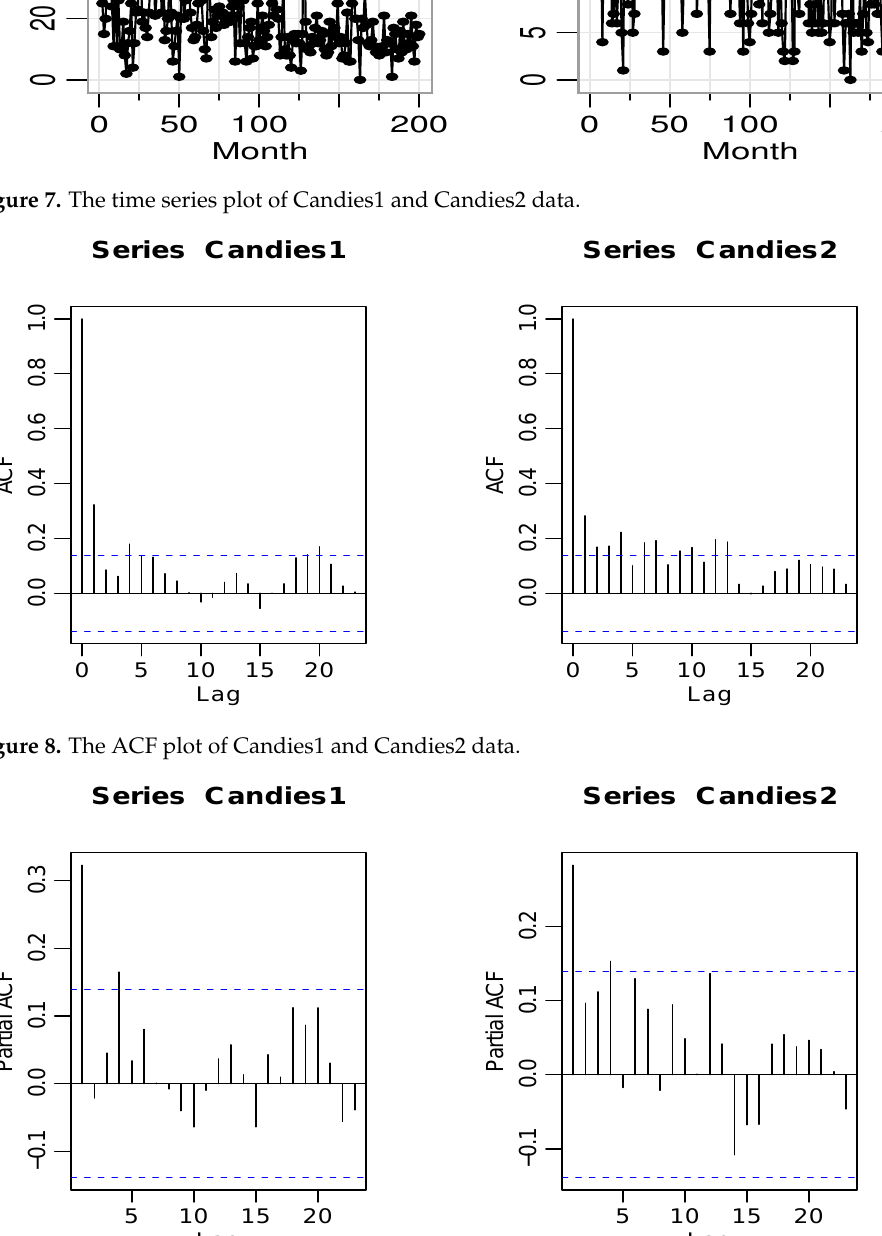
Figure 9. The PACF plot of Candies1 and Candies2